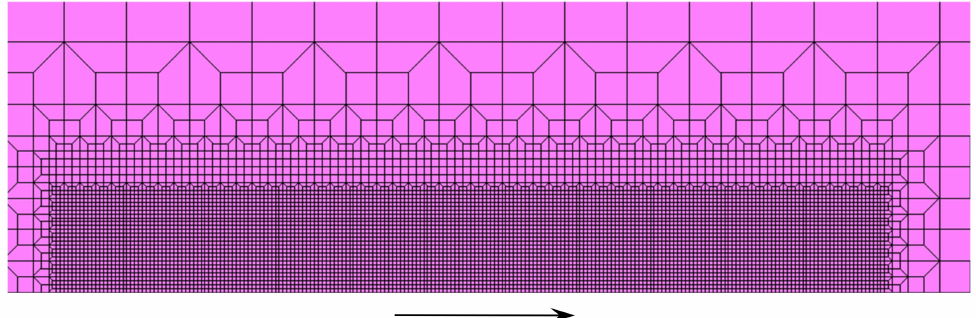
Figure 7. Finite element mesh near crack